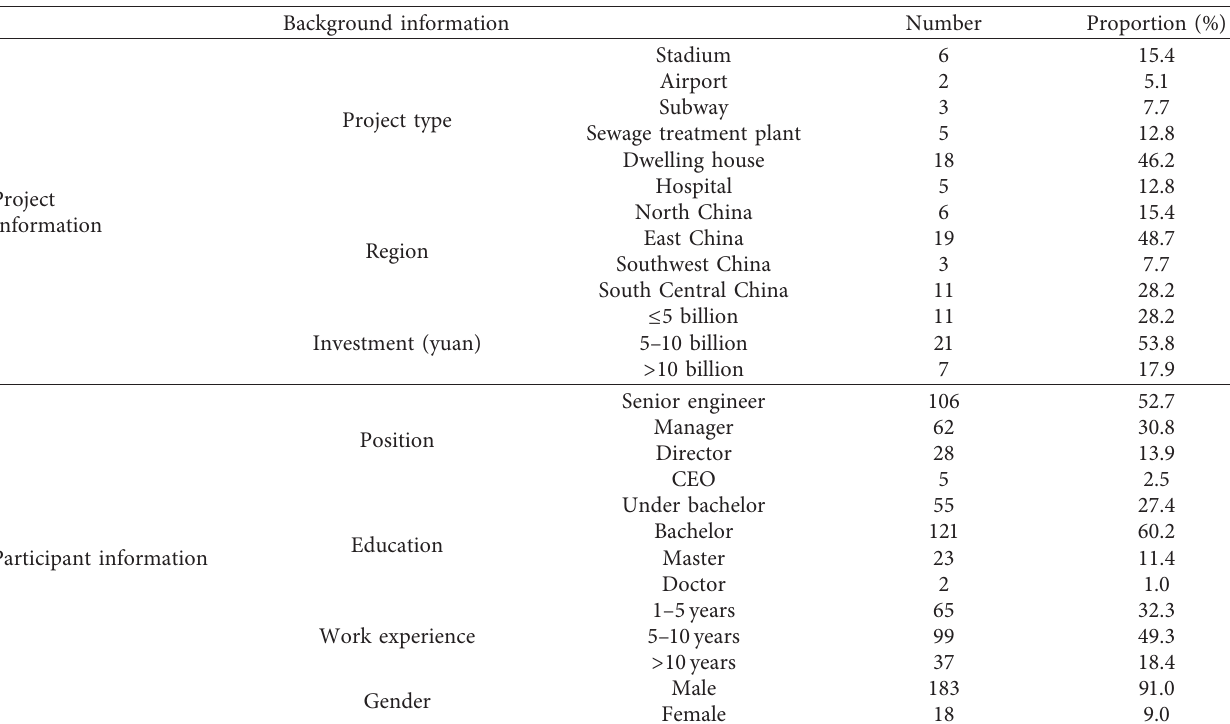
Figure 1: Research Table 1: Project and participant background information of selected 39 projects.